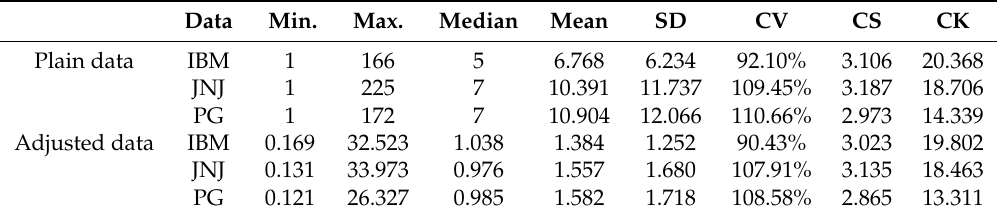
Table 3. Summary statistics for the International Business Machines (IBM), Johnson and Johnson Company (JNJ), and The Proctor and Gamble Company (PG) data